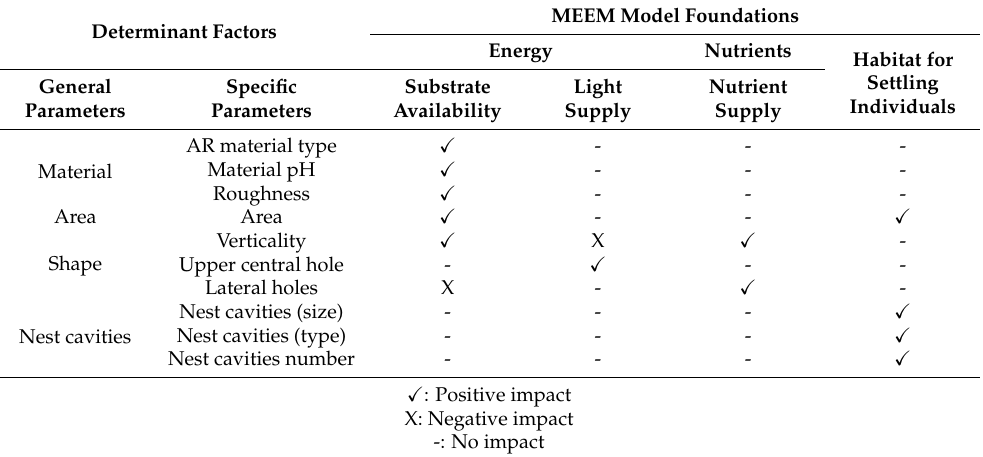
Table 2. Main parameters of an AR unit and their potential impacts in terms of energy, nutrients and new